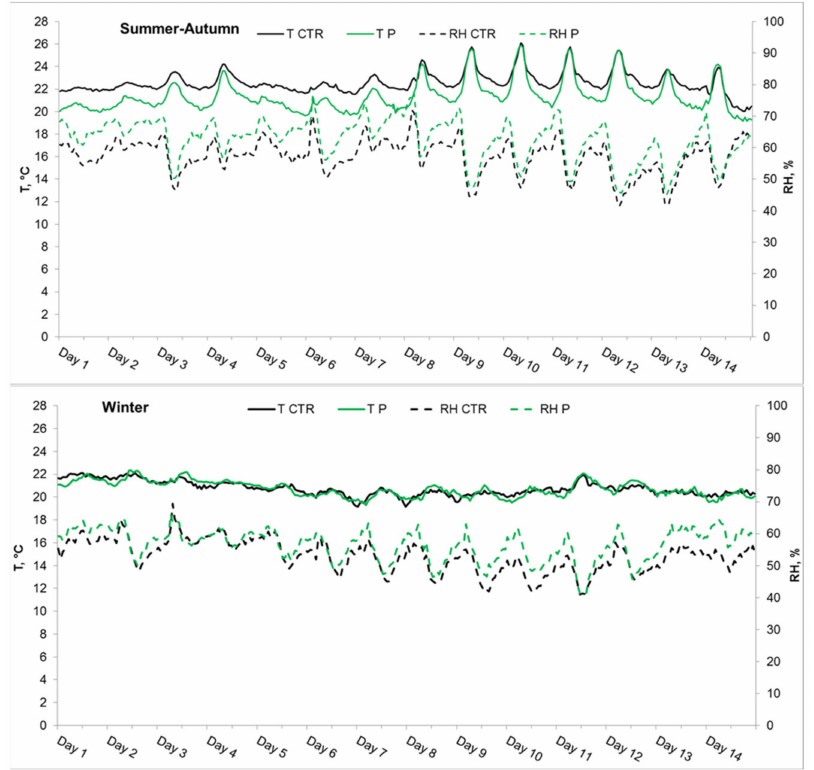
Figure 3. Temperature (T) and relative humidity (RH) in the compartments CTR and P in the two measuring periods (summer–autumn and winter). Table 2. Gas concentrations, ventilation rates (VR), temperatures and humidity in the compartments CTR and P for the last two weeks of the analysed growing periods (summer–autumn and winter).